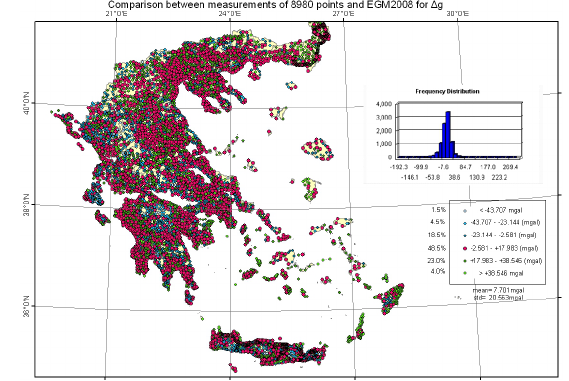
Figure 10: Geographical distribution of residuals in free-air gravity anomalies based on EGM2008 and terrestrial gravity data. Data refer to 8980 data points over the Hellenic